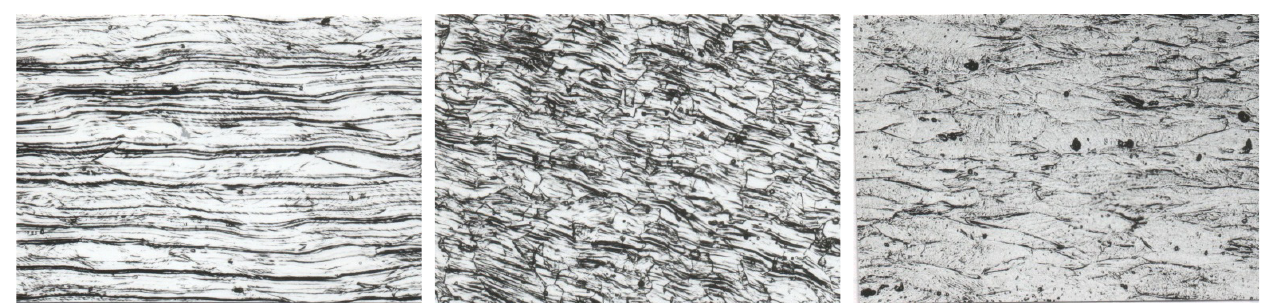
Figure 3a: “5” steel microstructure - Longitudinal section (x 200).